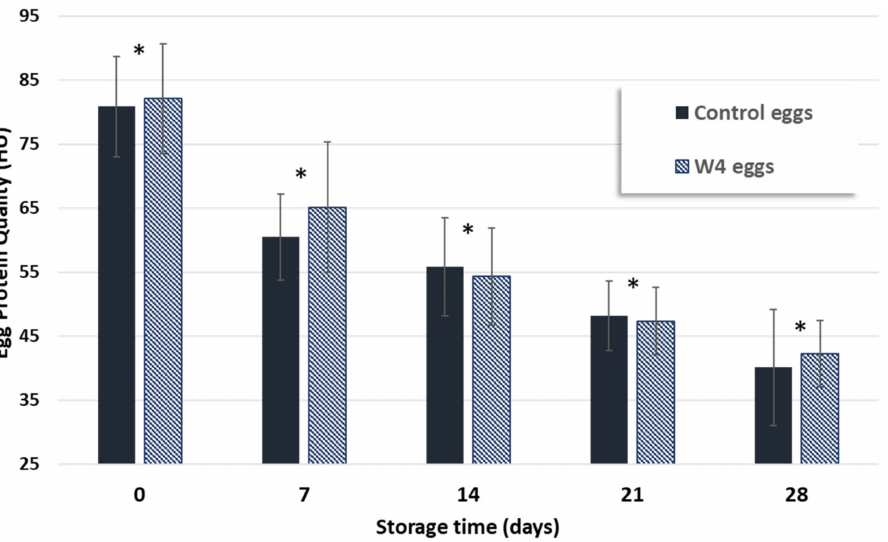
Figure 4. Comparison of protein quality (Haugh units, HU) of control eggs and W4 eggs (from hens fed with 3% of Nannochloropsis oceanica supplemented diet during the 4 weeks) along the storage time. * means statistically significant differences ( p < 0.05) between samples with different storage time (N =